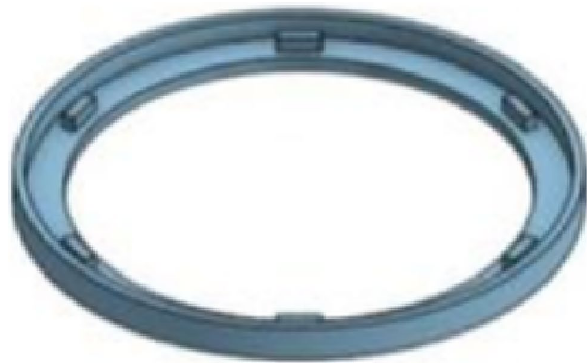
Figure 5. Airvent spacers support.